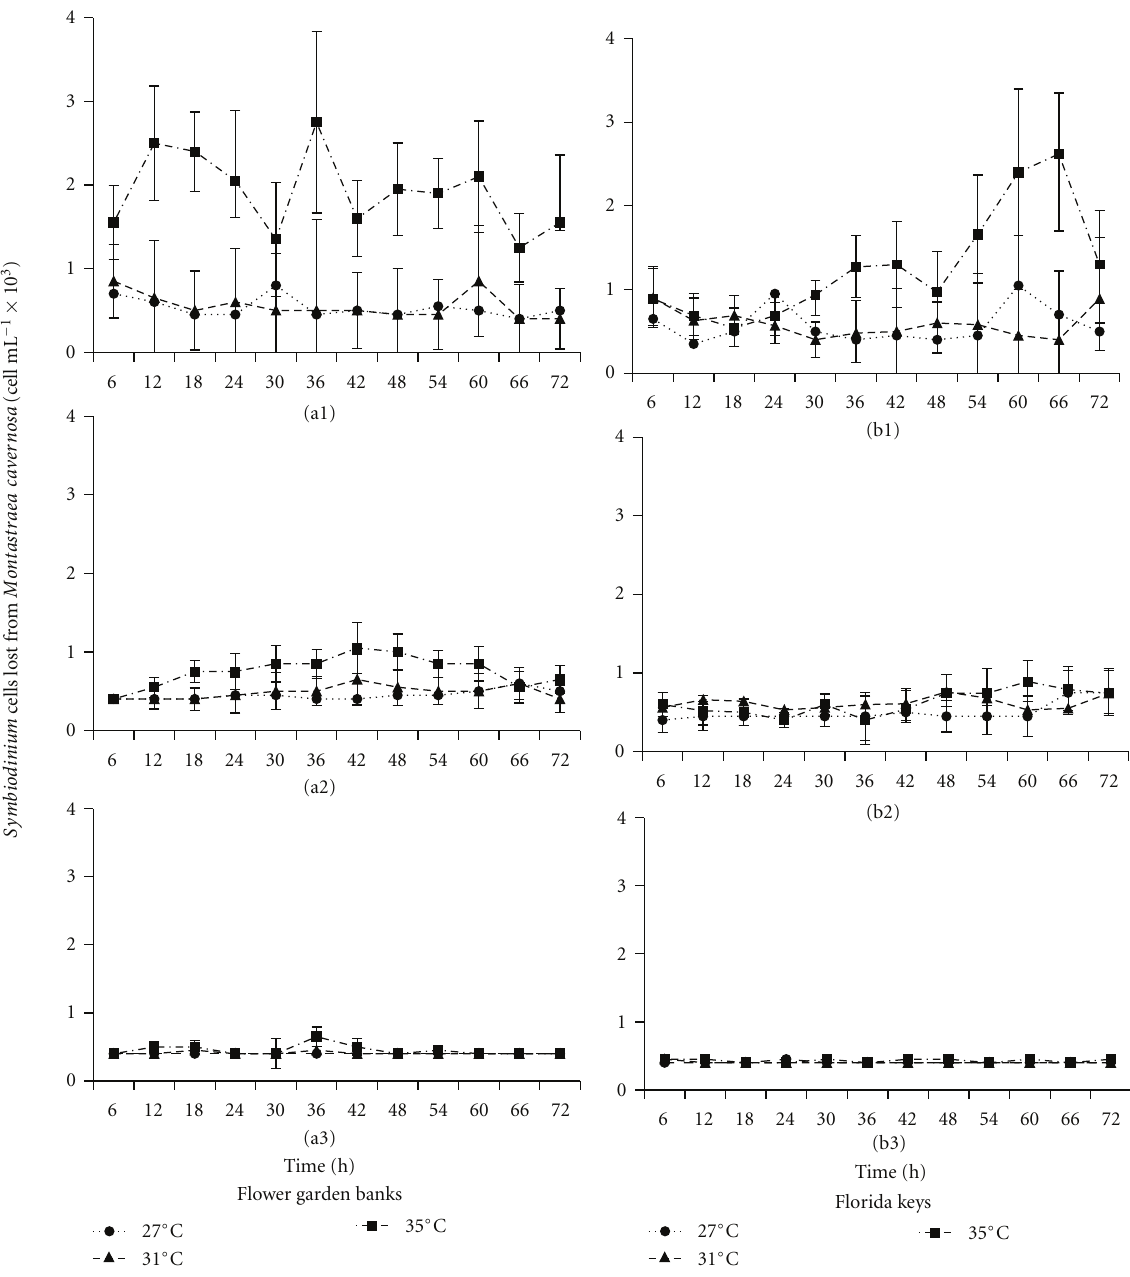
Figure 3: Hemocytometry data showing the mean temporal loss of viable (a1, b1), necrotic (a2, b2), and mitotic (a3, b3) zooxanthellae cells ( × 10 3 mL − 1 ) expelled from Montastraea cavernosa collected from the Flower Garden Banks National Marine Sanctuary (a1–3)) and the Florida Keys National Marine Sanctuary (b1–3)) sampled every 6h over a 72h time period at 27 ◦ C ( represent 95% confidence intervals ( n i = 8); some error bars are too small to be